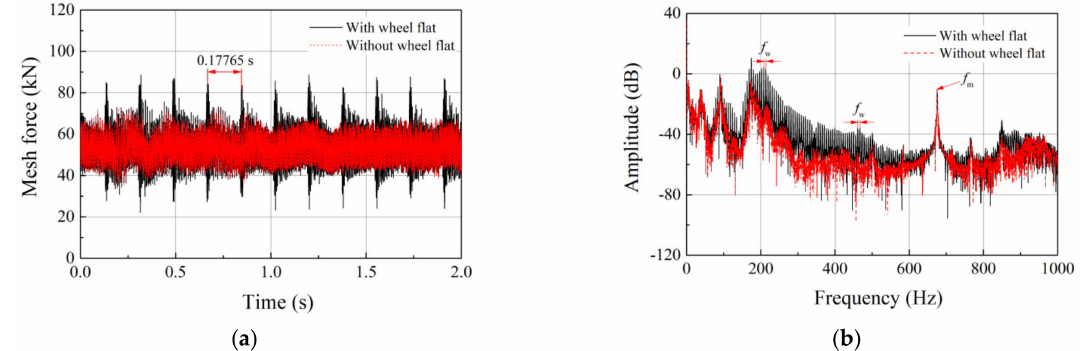
Figure 6. Time − varying mesh force: ( a ) time histories and ( b ) frequency